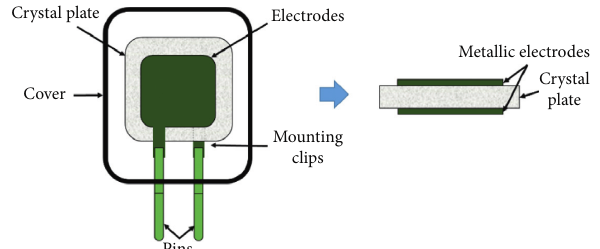
Figure 1: Model of the crystal